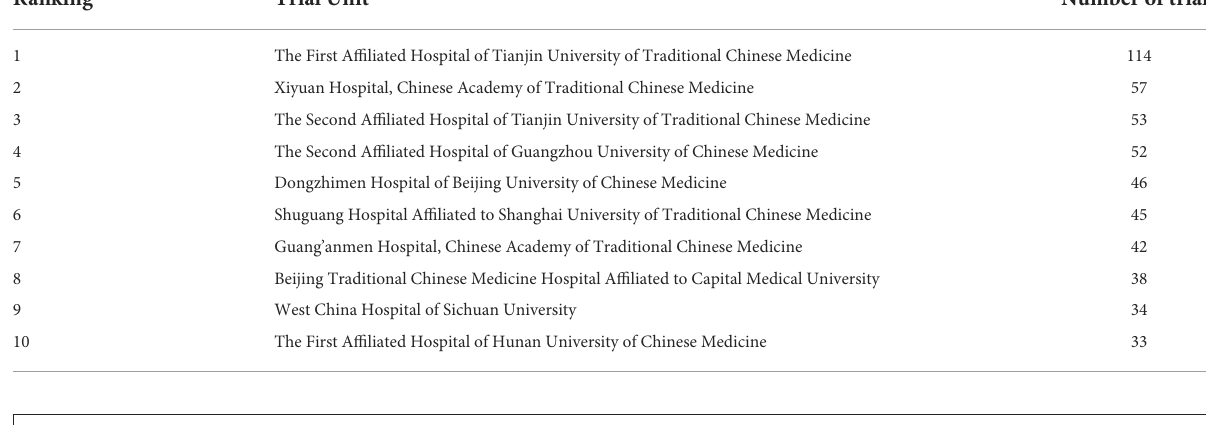
TABLE 3 Top 10 hospitals according to the number of TCM trials of clinical trial units from 2013 to 2021. Ranking Trial Unit